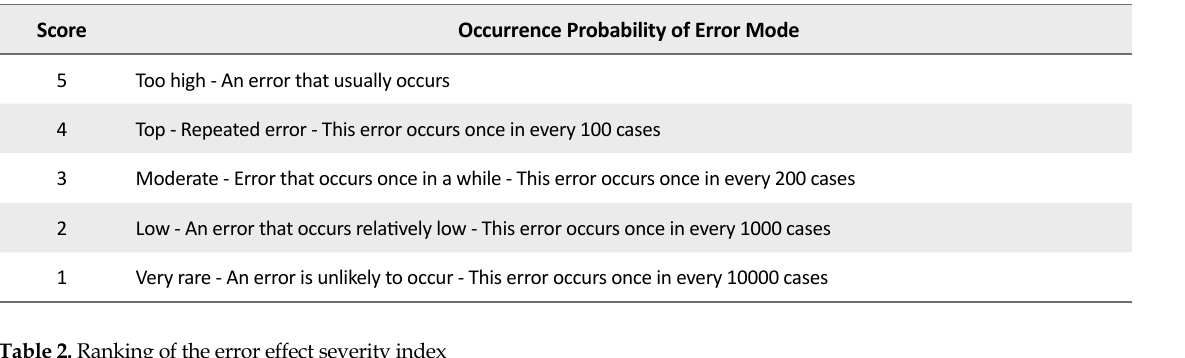
Table 2. Ranking of the error effect severity index Score